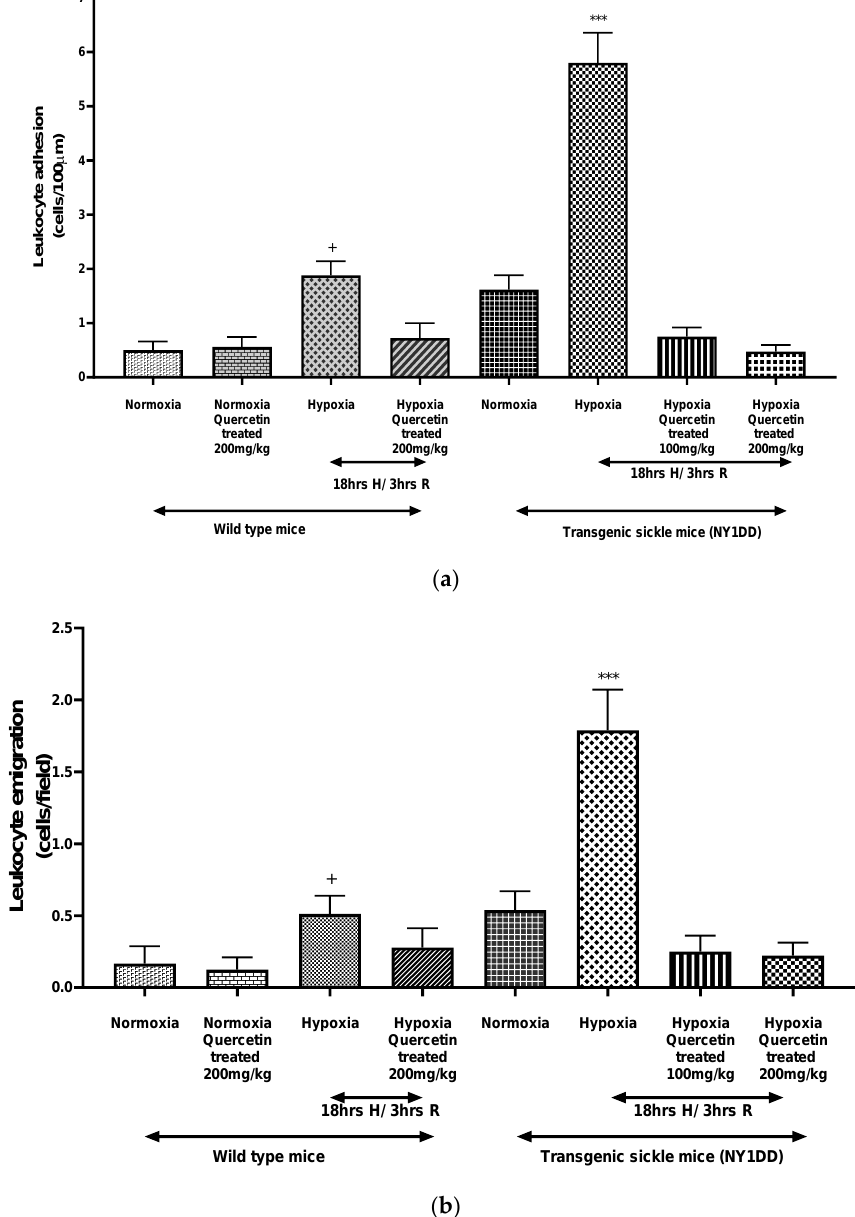
Figure 9. Comparison of the ability of H/R to induce vaso-occlusion in wild type mice vs. NY1DD mice and efficacy of quercetin to quench the H/R induced vaso-occlusive events. ( a ) Leukocyte adhesion; ( b ) leukocyte emigration. Values represent the mean ± SEM for four animals in each group; *** p < 0.0001 as compared to H/R-induced NY1DD mice treated with quercetin (100 and 200 mg/kg) and normoxic NY1DD mice; + p < 0.021 vs. normoxic wild type control. The efficacy of quercetin to ameliorate the H/R induced vaso-occlusion in wild type control mice was only partial, despite the fact that the level of vaso-occlusion was considerably lower, i.e., high therapeutic efficacy of quercetin is unique to transgenic mice NY1DD but not unique to quercetin itself. Apparently, the presence of mouse α -chain in NY1DD and/or of small amounts of mouse β -chain induces a higher quercetin therapeutic efficacy in ameliorating the vaso-occlusion in NY1DD. The higher oxygen affinities of chimeric HbS in NY1DD composed of mouse α - chain and human β S -chain, or composed